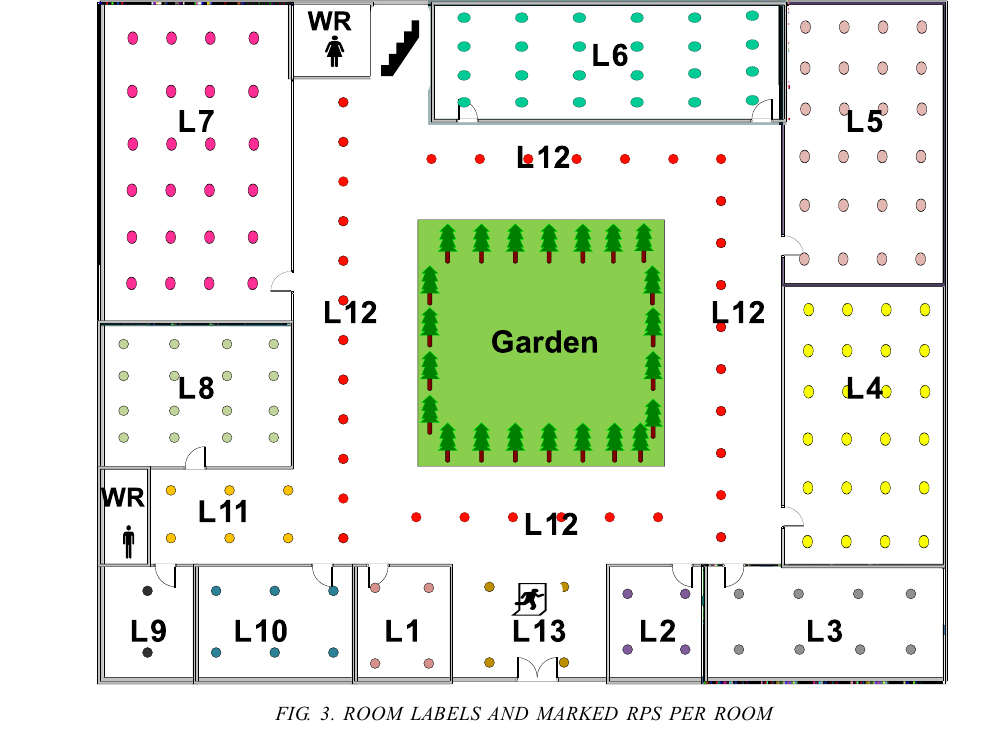
FIG. 3. ROOM LABELS AND MARKED RPS PER